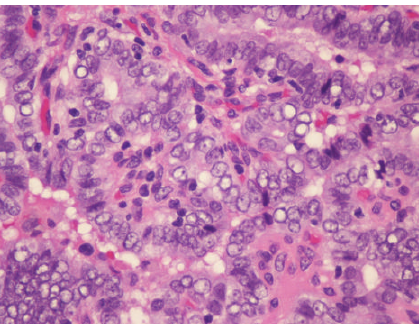
Figure 3: High power (40x) microscopy of the lateral neck mass showing cells with enlarged nuclei, intranuclear cytoplasmic inclusions, nuclear grooves and powdery chromatin which is diagnostic for papillary thyroid